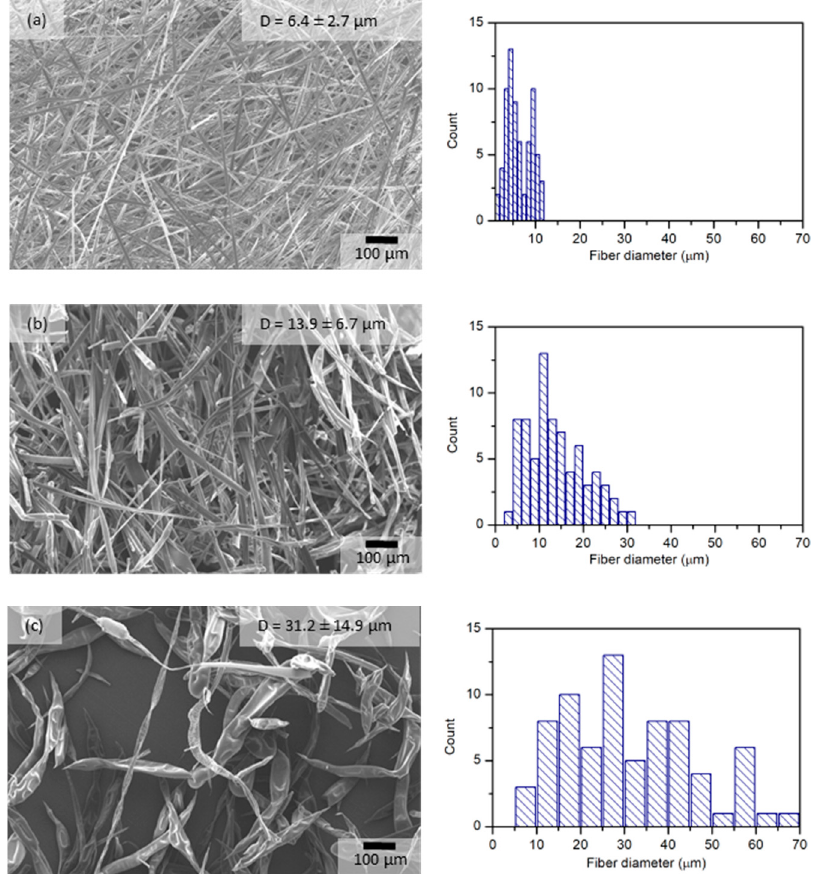
Figure 2. Comparison of fiber morphology and fiber diameter distribution of electrospun samples